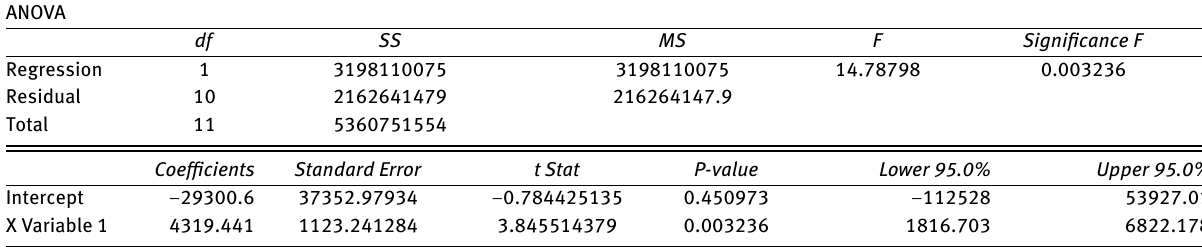
Table 3: Regression Statistics using